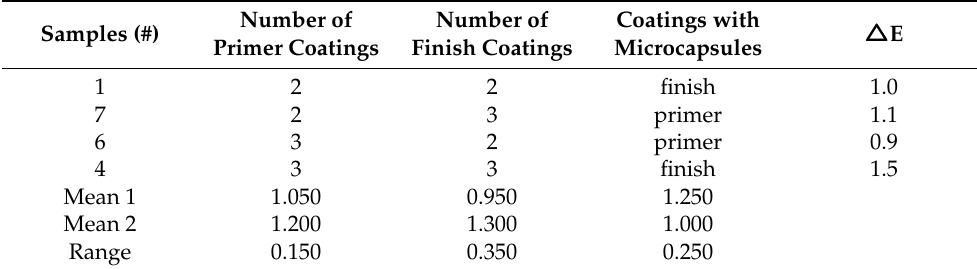
Table 3. Analysis results of the orthogonal